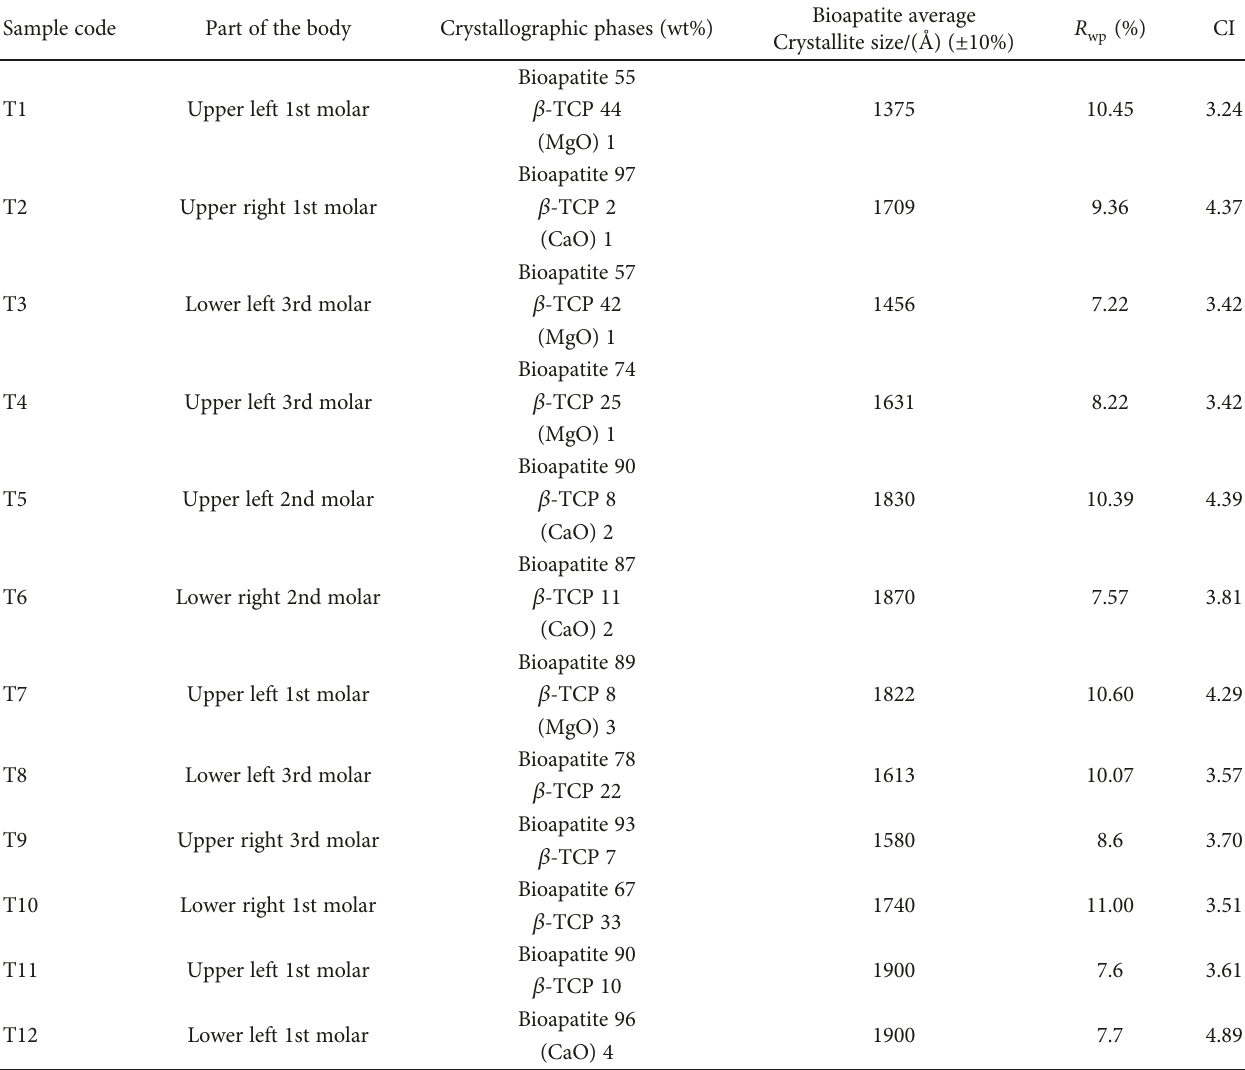
Table 2: List of structure and microstructure parameters of bioapatite structure in teeth from phase analysis by XRD and the associated ATR- IR